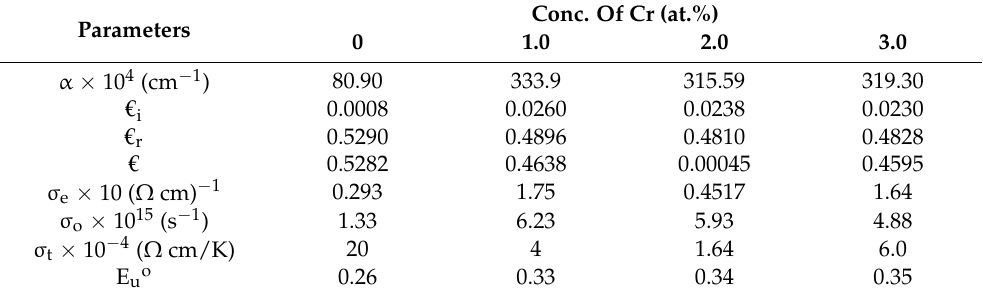
2 S 3 thin films. Conc. Of Cr